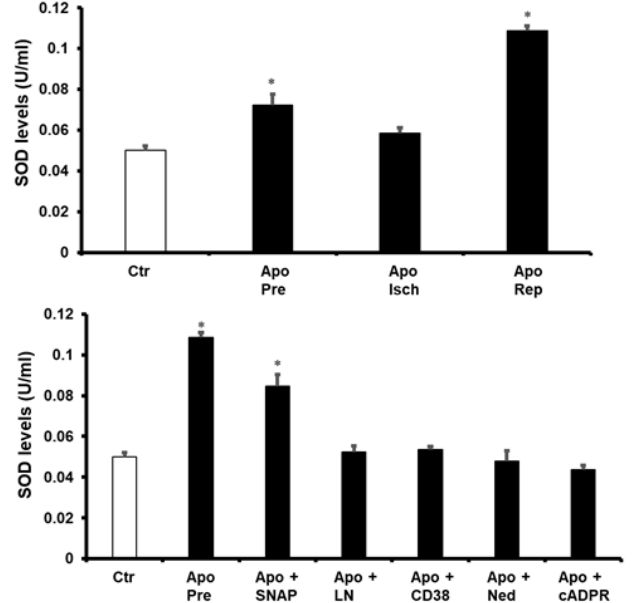
Figure 6. The levels of the antioxidant enzyme SOD in heart homogenates in all experiments. Quantification of SOD in hearts treated with apocynin or a combination of apocynin and SNAP, L-NAME, 78c, Ned, or cADPR agonist (n = 4 per group). Data are shown as means ± SEM. Ctr, control; Apo, apocynin; Pre, apocynin before ischemia; Isch, apocynin during ischemia; Rep, apocynin at reperfusion; SNAP, nitric oxide donor, LN, L-NAME; 78c, CD38 blocker; Ned, NAADP inhibitor; cADPR agonist. * p < 0.05 compared to controls.